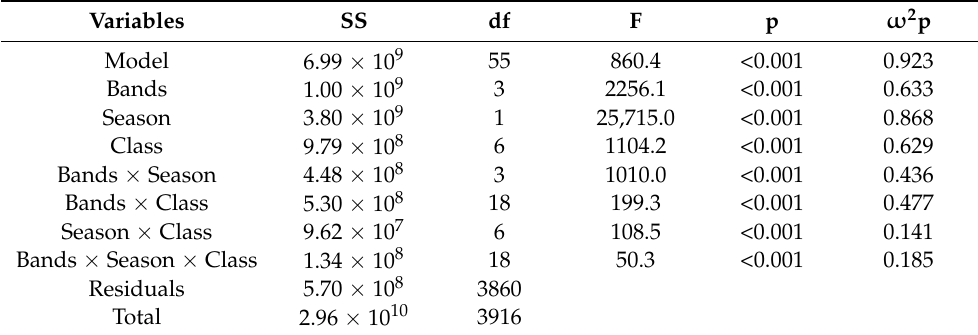
Table 1. Results of General Linear Modelling (GLM) performed with reflectance as an independent variable (SS: Sum of Squares, df: degree of freedom, F: F-statistic, p: significance, ω ²p: effect size; p < 0.05: significance level).